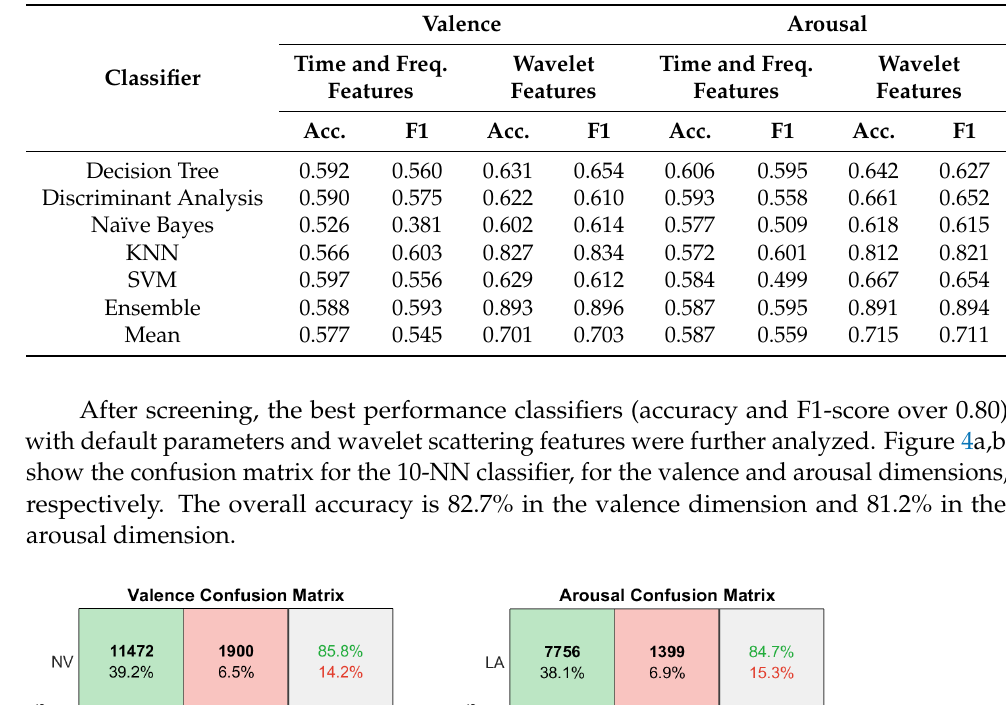
Table 1. Classifier screening in one dimension using short and long experiment data.